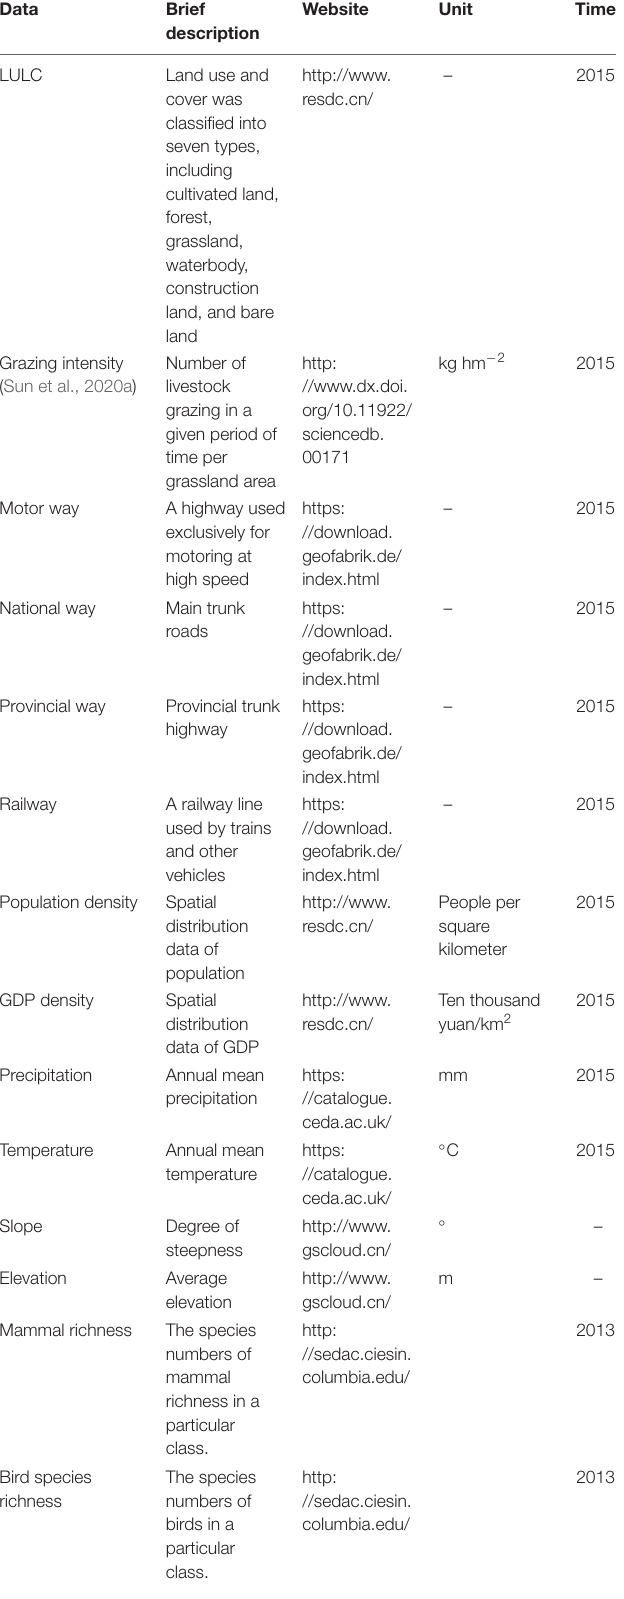
TABLE 1 | The brief description, website, unit, and time of